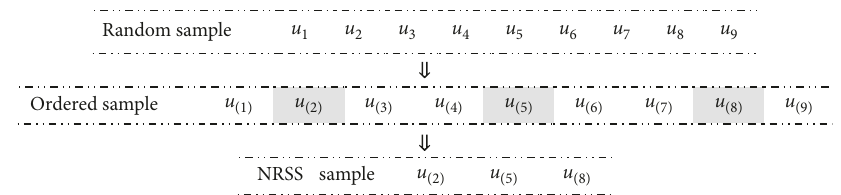
Figure 4: Display of m 2 observations in one cycle and the selected NRSS sample of size m �